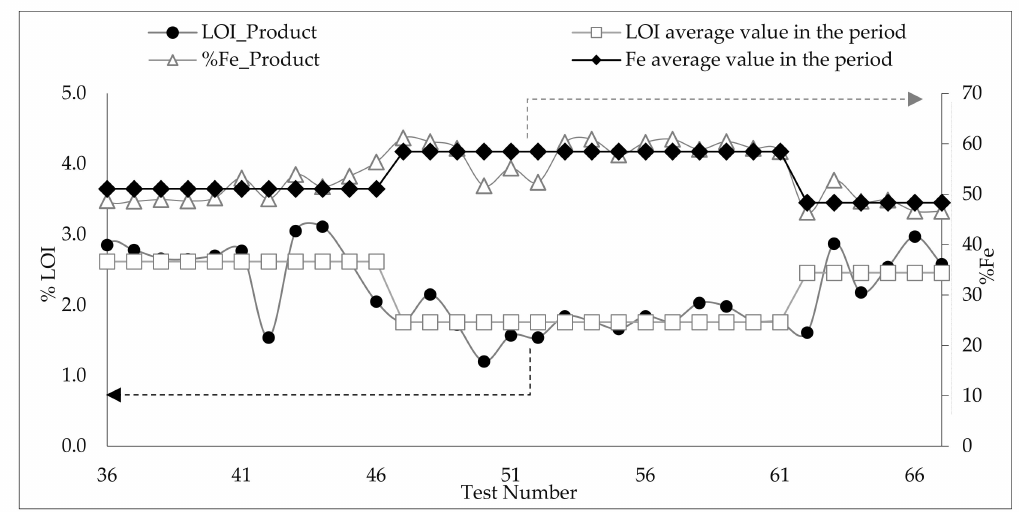
Figure 24. Trend regarding the reduction of the iron content in the product with the increase in the value of LOI for this